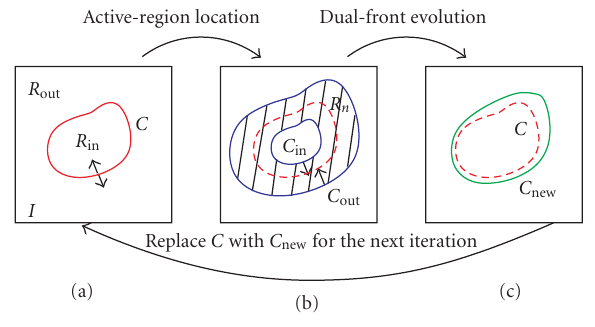
Figure 1: Iteration process of dual-front evolution and active- region location. (a) An initial contour C separates image I to two regions R in and R out ; (b) the curve C is dilated to form a narrow active region R n ; (c) the inner and outer boundaries C in and C out of R n are set as the initializations of two minimal action maps U C and U C , and the set of meeting points of the level sets of U C out forms a new minimal partition curve C new inside R n . C new di- U C out vides image I into two regions. Curve C is replaced by curve C new for the next